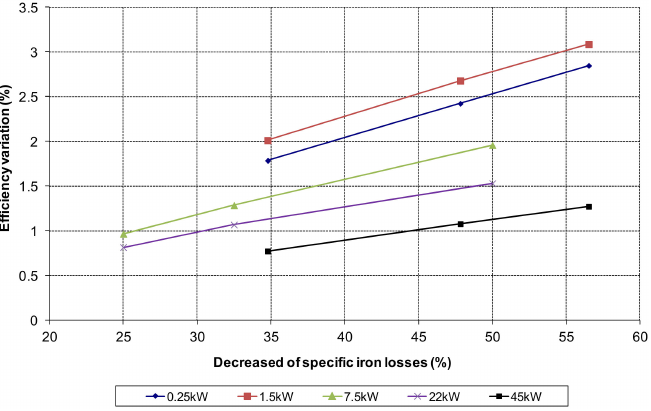
Figure 17. Efficiency variation versus decreased of specific iron losses in all the motors (equal output power